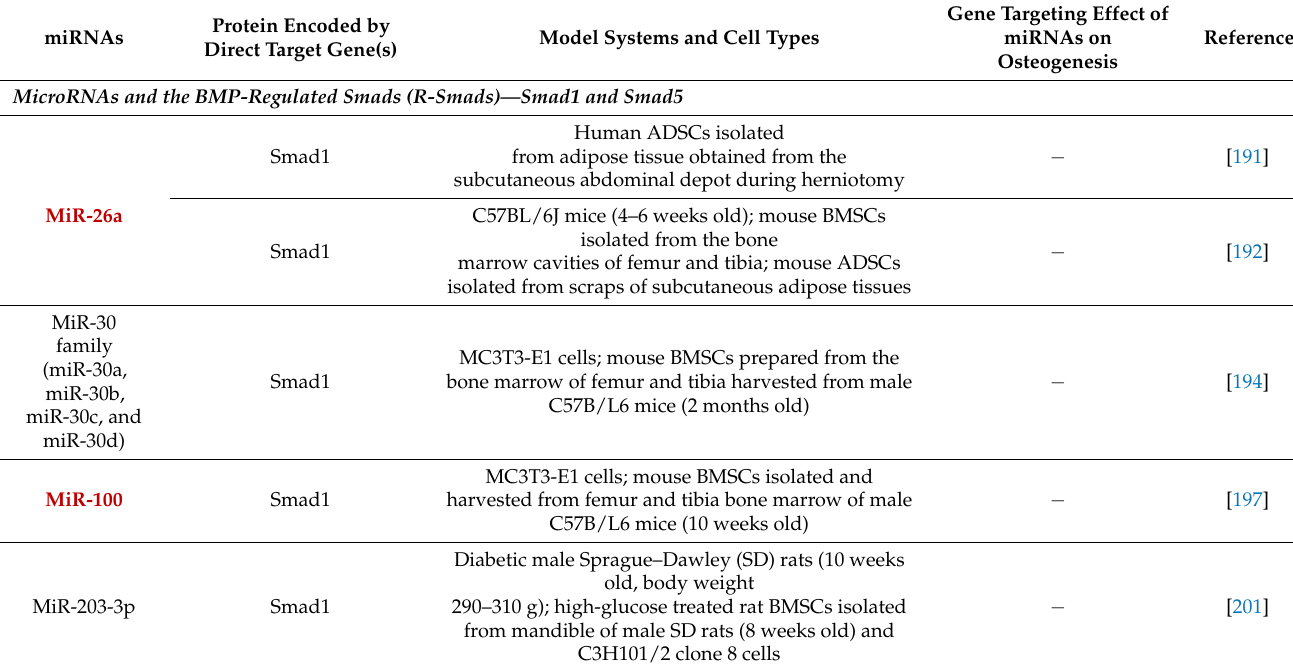
Table 3. List of microRNAs implicated in Smad signalling cascades in various model systems and cell